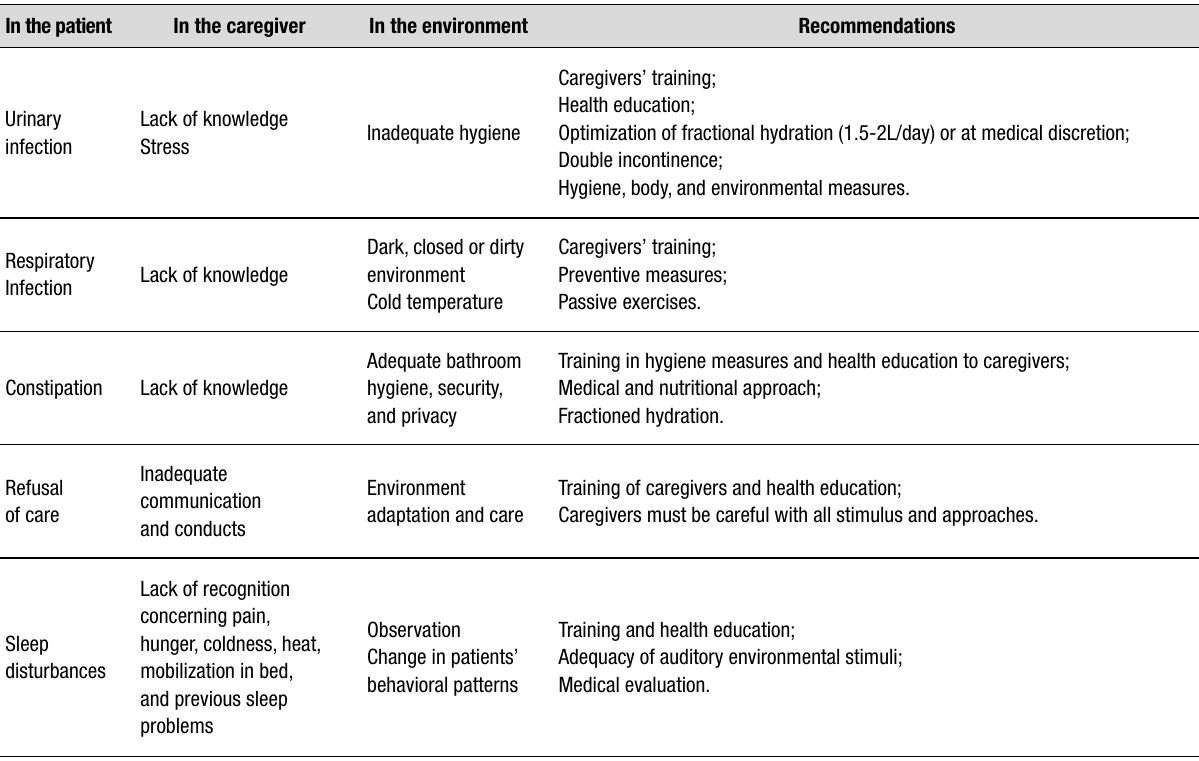
Table 3. Continuation.